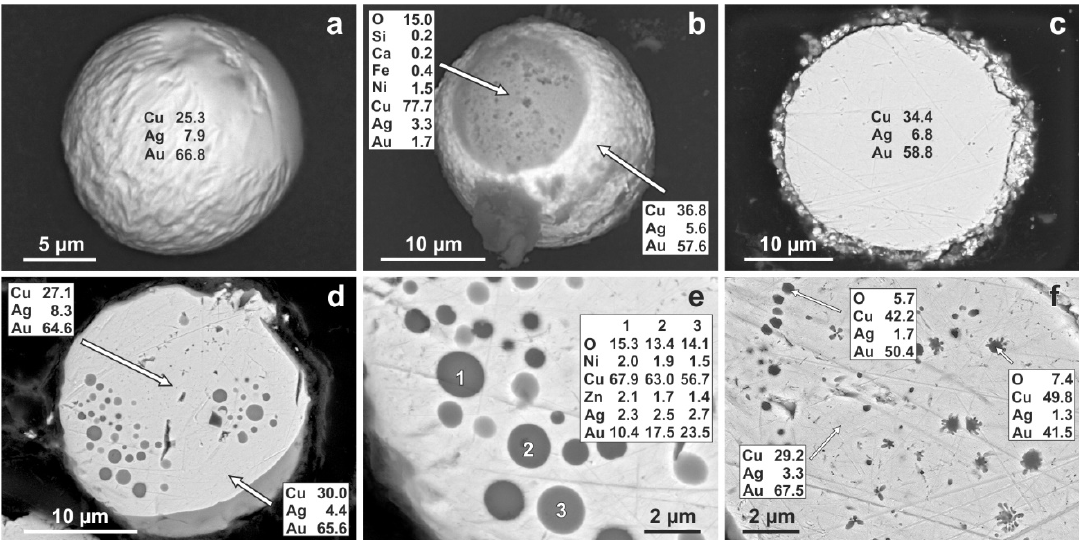
Figure 11. Gold-bearing spherules in carbonatite-like rocks from the Poperechnoye deposit: ( a )—sculptured spherule exterior with multiple compaction-related deformations; ( b )—internal structure of a homogeneous spherule; ( c – f )—internal structures of gold-bearing spherules with copper oxide rim ( c ), and spherical ( d , e ) or dendritic ( f ) copper oxide inclusions.